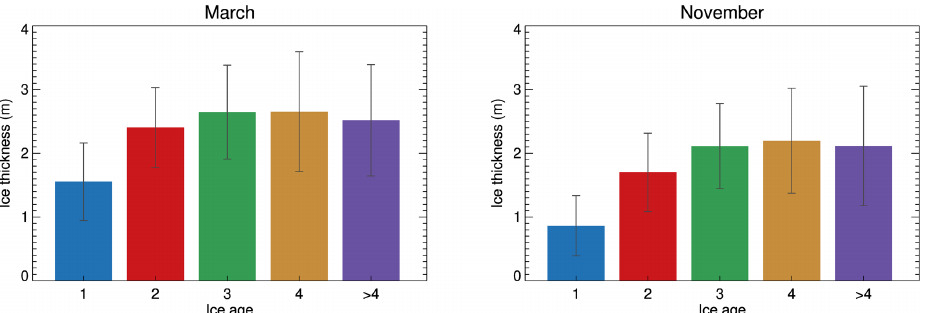
Figure 12. Ice age versus ice thickness from collocated ice age and AWI CryoSat-2 ice thickness. The error bar shows 1 standard deviation above and below the mean ice thickness in each ice age category.